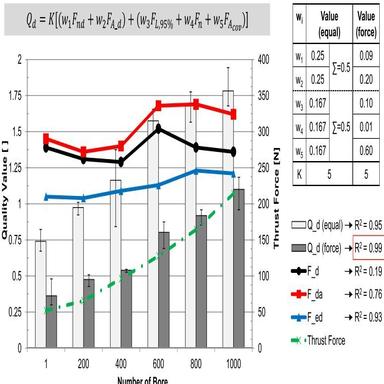
Development of different quality factors over a sequence of 800 holes in UD CFRP. The Qd with weighting factors adapted to the thrust force correlates best with the wear of the tool .